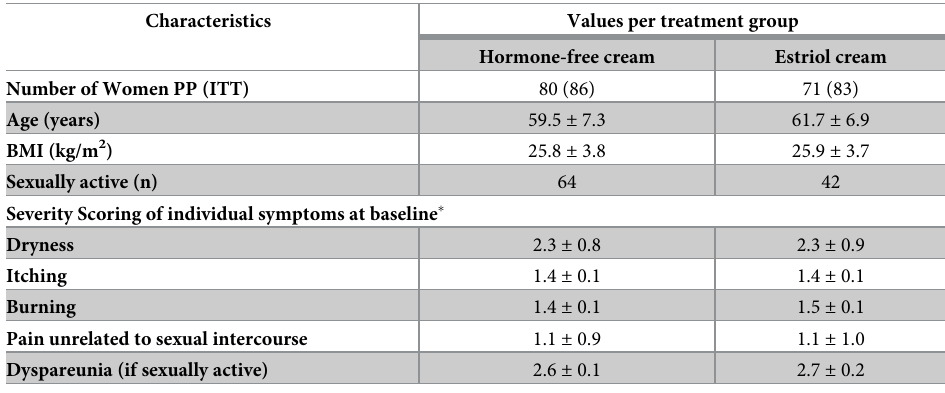
Table 1. Demographic and baseline